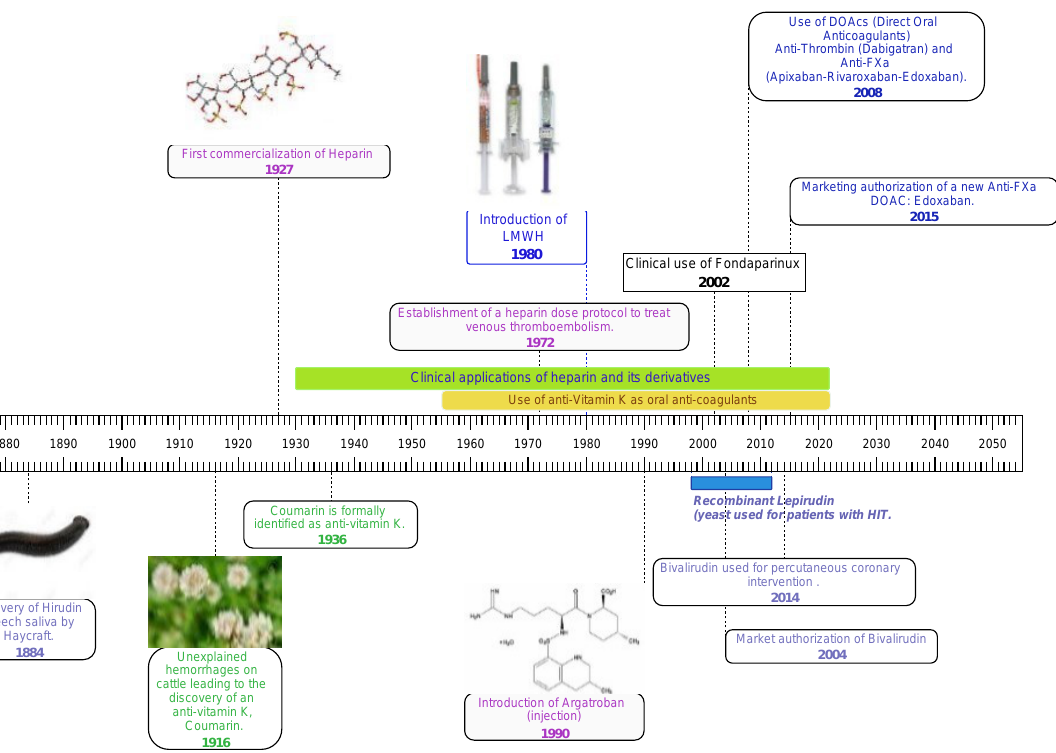
Figure 1. Schema showing the timescale for the discovery and introduction of the various anticoagu-